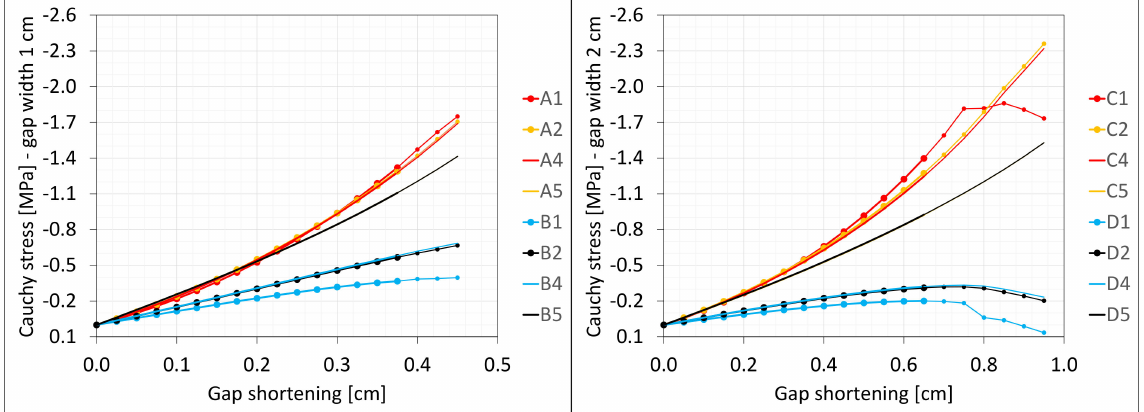
Figure 6. Equilibrium paths for stresses σ z in selected nodes. The width of the gap is equal to 1.0 cm, left graphic, and 2.0 cm, right graphic. Parts of charts with non-physical deformations are displayed with thin